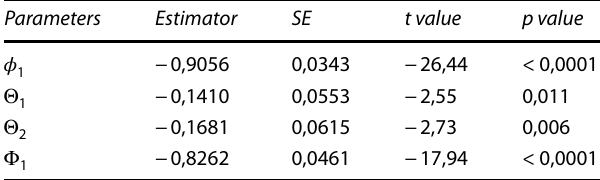
Table 4 Estimated parameters for SARIMA